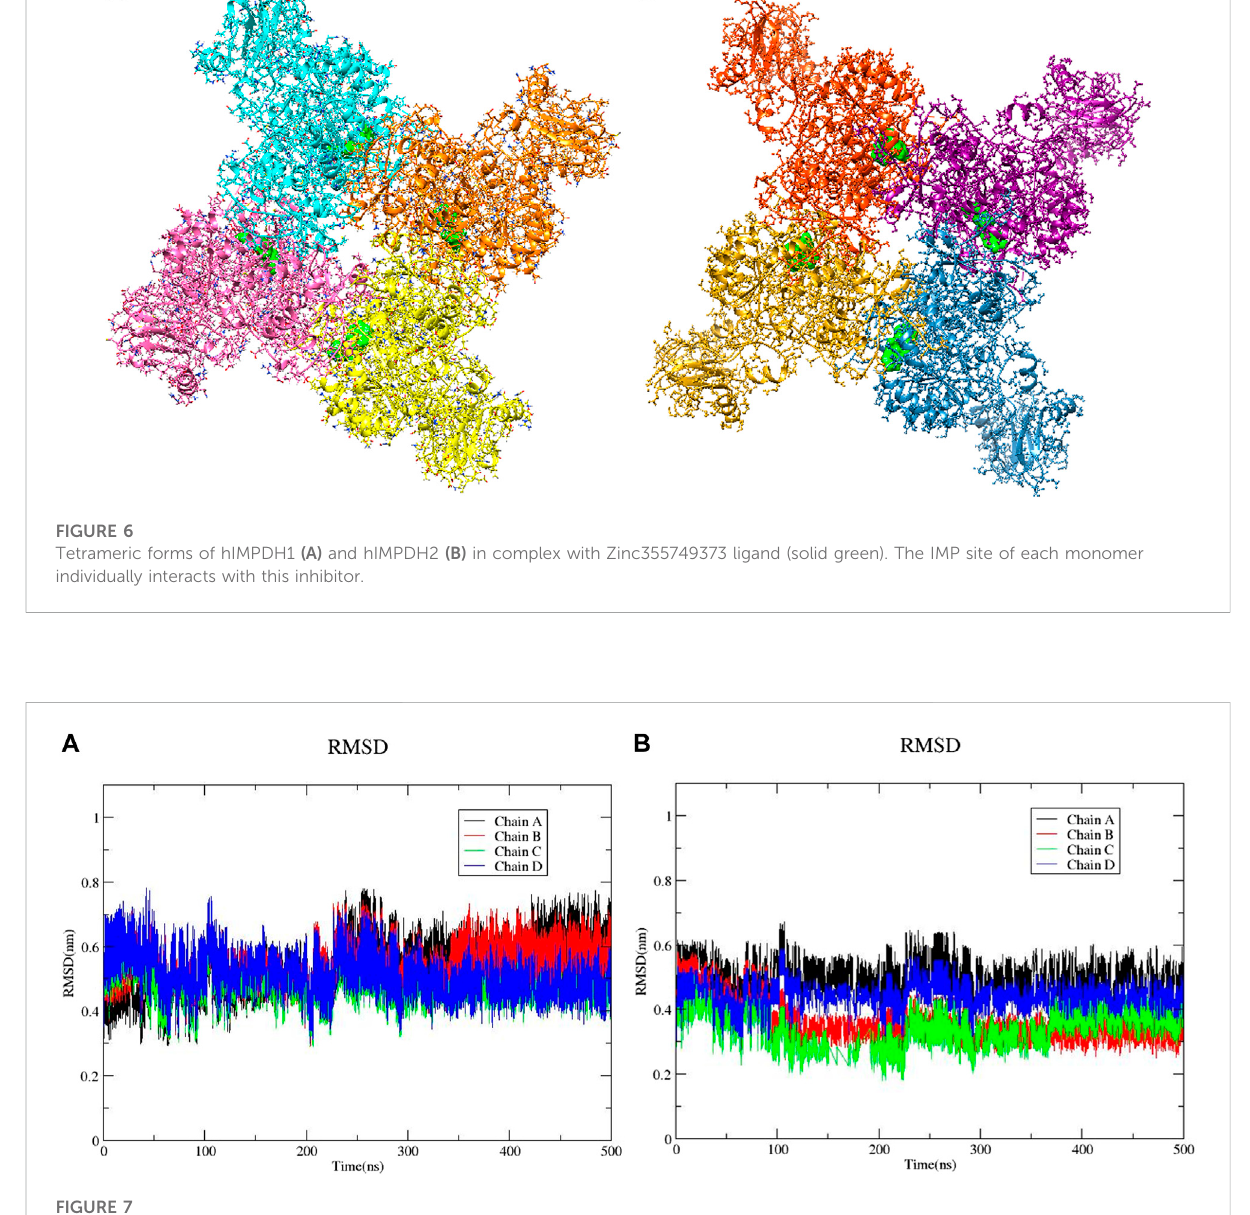
FIGURE 7 RMSD plots of 1hIMPDH-Zinc355749373 (A) and 2hIMPDH-Zinc355749373 (B) tetrameric complexes during the course of 500 ns simulation time.